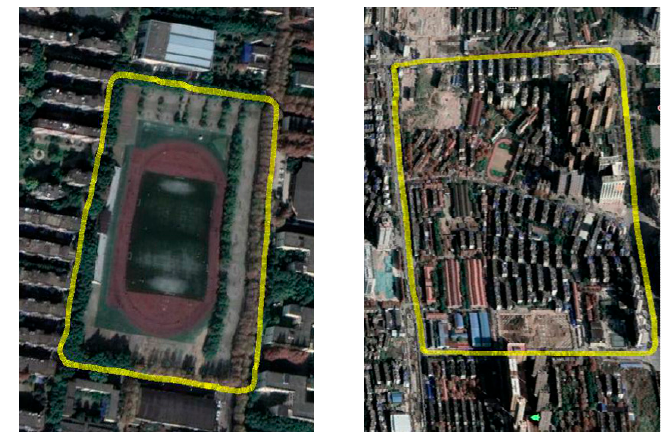
Figure 7. Test route around Youyi road.